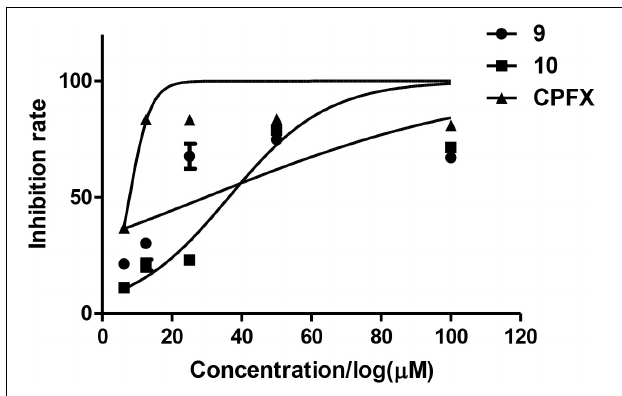
FIGURE 9 | Inhibition rates of A. salmonicida of compounds 9 and 10